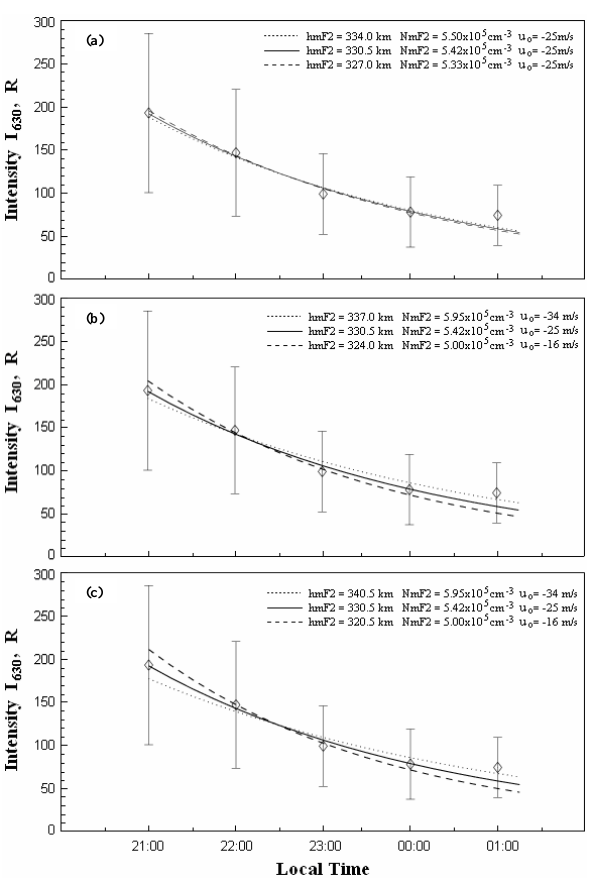
Fig. 4. Night variations of the red line intensity I 630 (t) observed in April (diamonds) and their theoretical values for the following cases: u 0 =− 25m/s, decrease in densities of [ N 2 ] , [ O 2 ] and [O] by 5% and temperature T n by 1% (full lines), absence of decrease in the densities of neutrals and temperature (dotted lines), u 0 =− 25m/s (panel a ), u 0 =− 14m/s (panels b and c ), and decrease in the den- sities of neutrals by 10% and temperature by 2% (dashed lines), u 0 =− 25m/s (panel b) and u 0 =− 34m/s (panels b and c ). Vertical lines are one sigma error